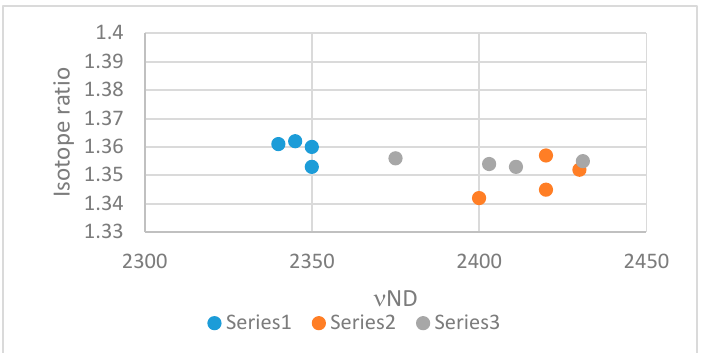
Figure 27. Plot of the ν NH/ ν ND ratio vs. ν ND. Series 1 β‐ amino ‐α‐ nitro ‐α , β‐ unsturated ketones, hydrogen bonding to the keto group, Series 2 Hydrogen bonding to the nitro group from [89] and Series 3 enaminoesters from [89,103].